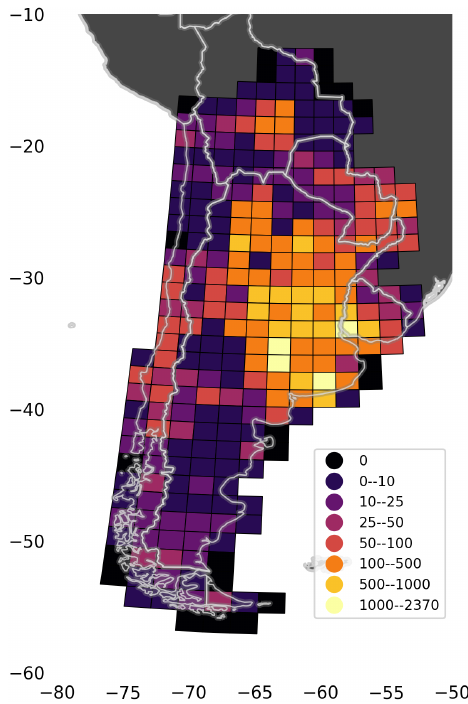
Figure A1. Count of training polygons within each 150 km × 150 km grid